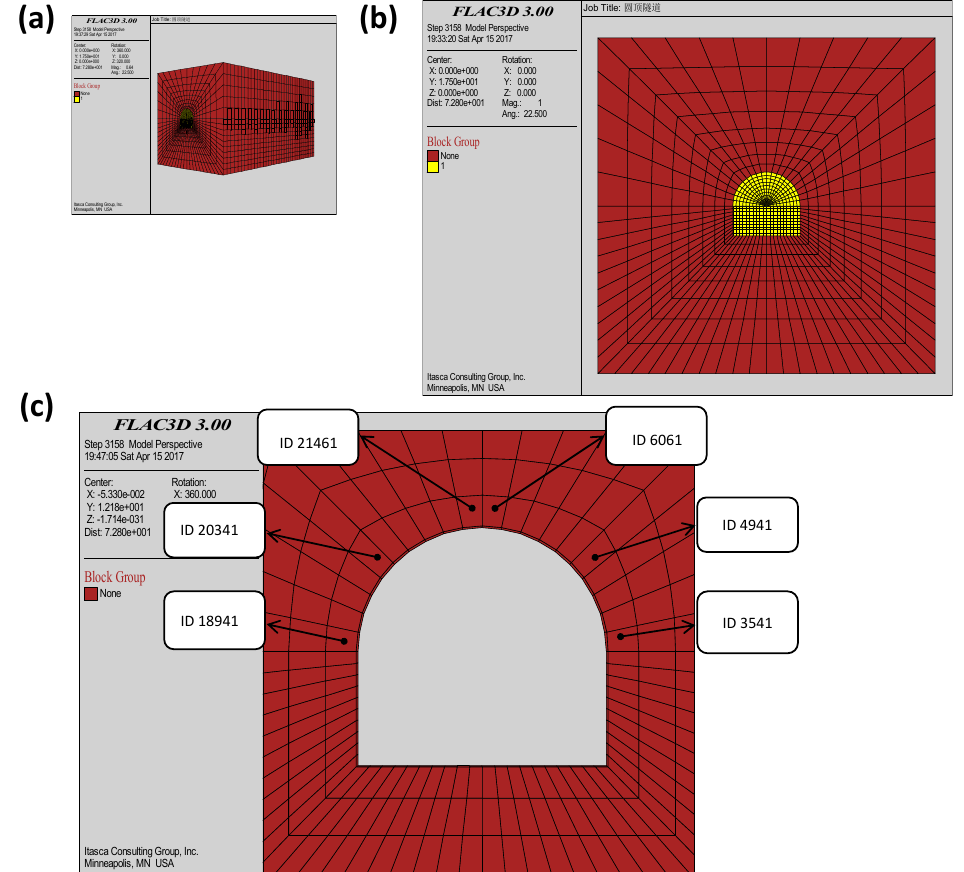
Figure 3. FLAC 3D model for ELM: ( a ) the entire model, ( b ) front view of the model and ( c ) model after excavation.